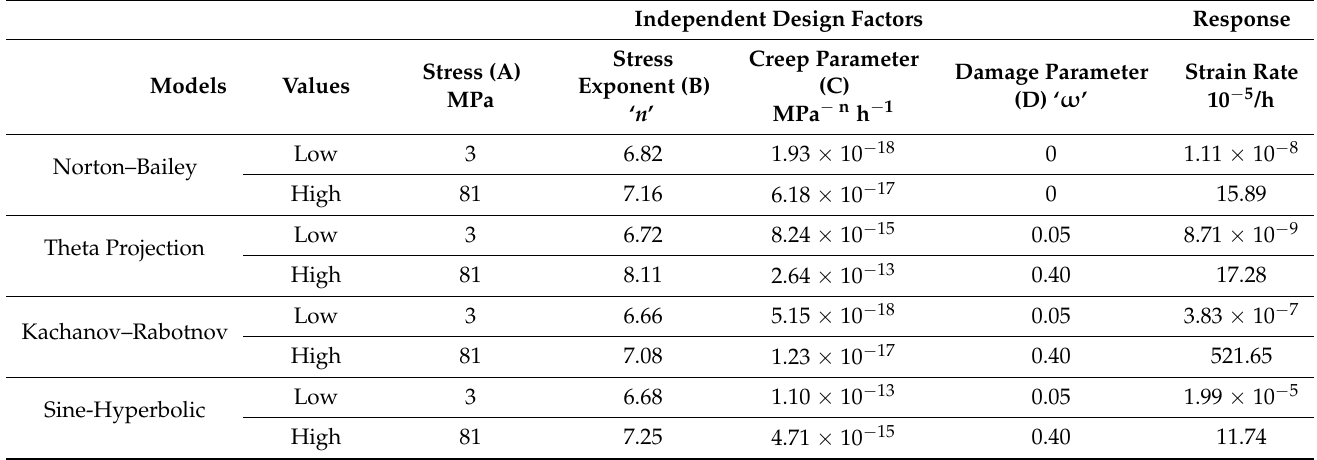
Table 4. Independent design factors and response for